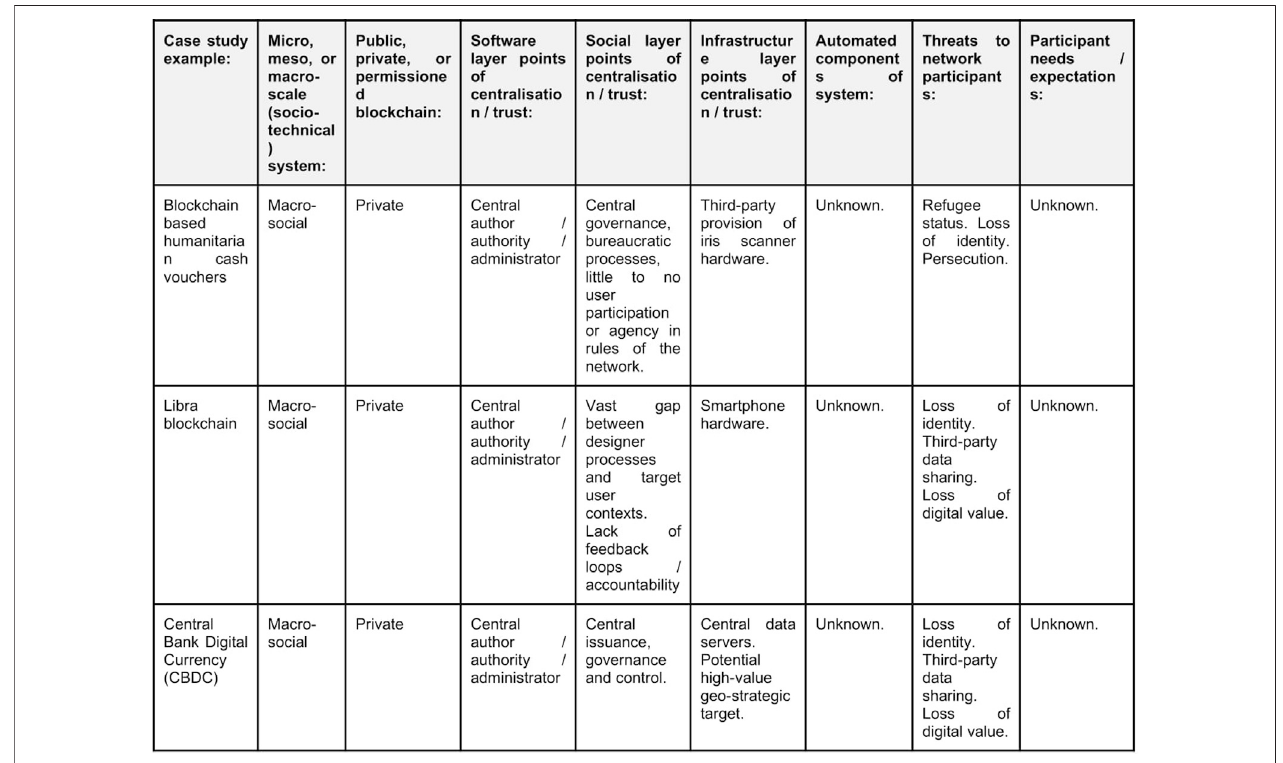
FIGURE 1 | “ People security ” analysis framework, applied to blockchain case